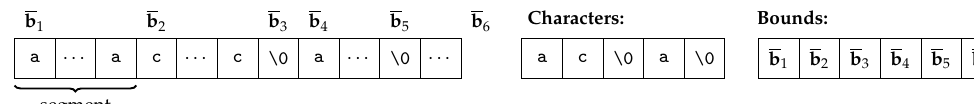
Figure 3. M-String value with symbolic bounds, where string of interest is from b 1 to b 3